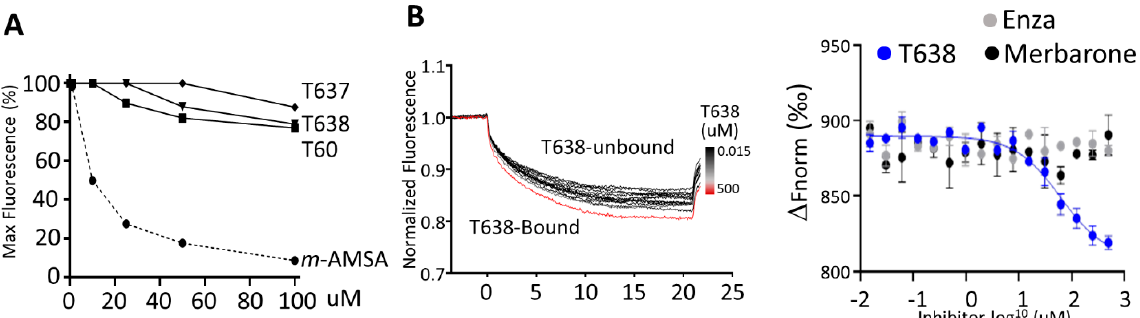
Figure 4. T638 does not intercalate with DNA but binds to TOP2 protein. ( A ) Ethidium bromide displacement assays were performed by mixing 100 µg/mL salmon sperm DNA with − /+2 µg/mL ethidium bromide and the indicated compounds. Reactions were subjected to fluorescence emission of 590 nm and excitation of 535 nm. Obtained signals were detected by using the Multimode Microplate Reader (Infinite F500). ( B ) MST assay was performed by incubating 5 nM of the purified human TOP2A(431-1193) labeled with the red fluorescent dye NT647 in the presence of vehicle or 0.015–500 µM of T638. Reactions were subjected to 5–20% LED/excitation power and medium MST power using premium capillaries. Obtained signals were detected by using the Monolith NT.115 system. The change in thermophoresis is expressed as the change in the normalized fluorescence ( Δ F norm ). MST assays were repeated with two control compounds, enzalutamide (Enza) and merbarone.